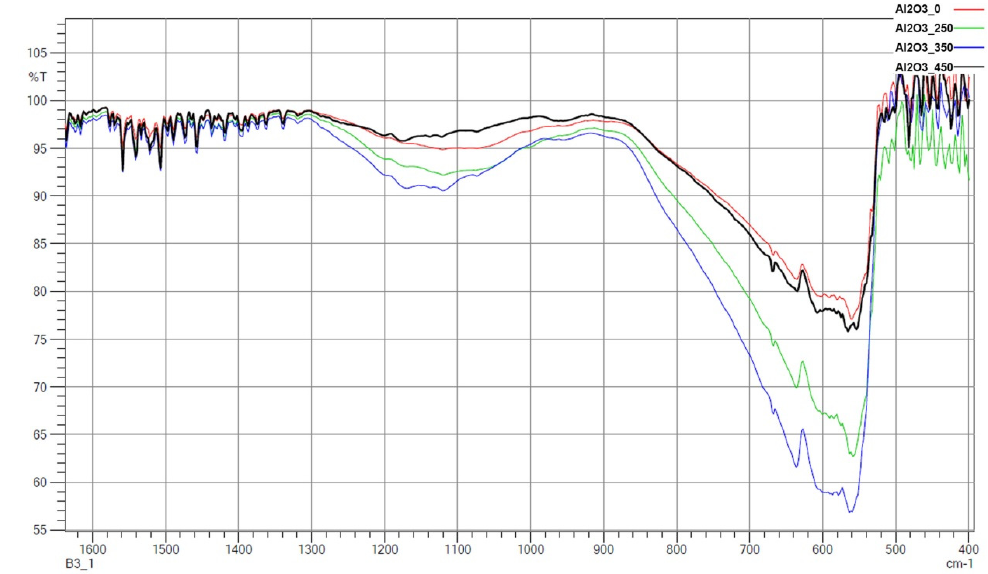
Figure 10. FTIR spectra of all APTES-modified alumina samples.